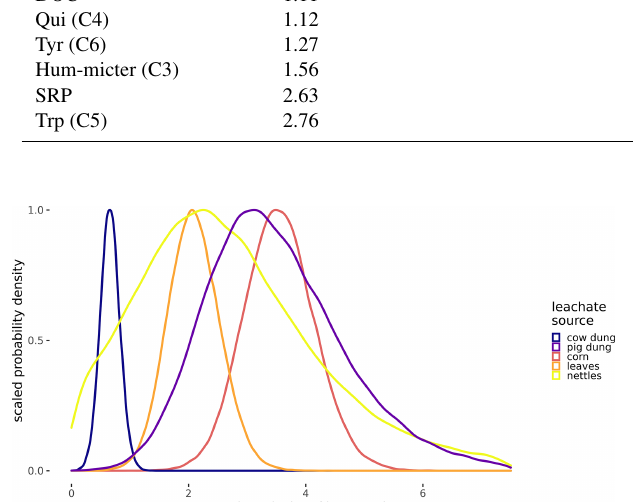
Figure 5. Posterior density distribution curves of uptake velocity v f of DOC depending on the leachate source.